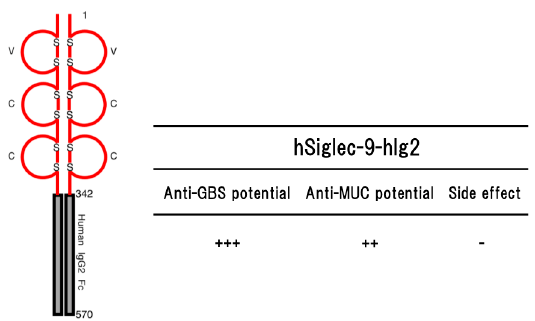
Figure 3. Schematic representation of a soluble form of human Siglec-9 (hSiglec-9-hIg2) consisting of the ectodomain of human Siglec-9 and Fc portion of human IgG2 (left part) and their potential (anti-GBS [79] and anti-MUC [88]) in the transgenic mice are shown (right part). Numbers on the figure are shown amino acids number of each molecule. S represents disulfide bond. + to +++ indicate relative strength of the phenotype. − means no phenotype observed.